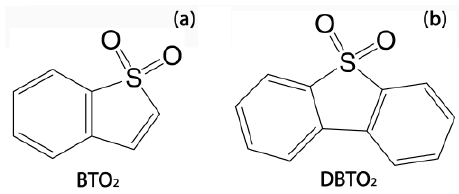
Figure 1. Chemical structures of organic sulfones used in the study: benzothiophene sulfone (BTO 2 ) ( a ) and dibenzothiophene sulfone (DBTO 2 ) ( b ).